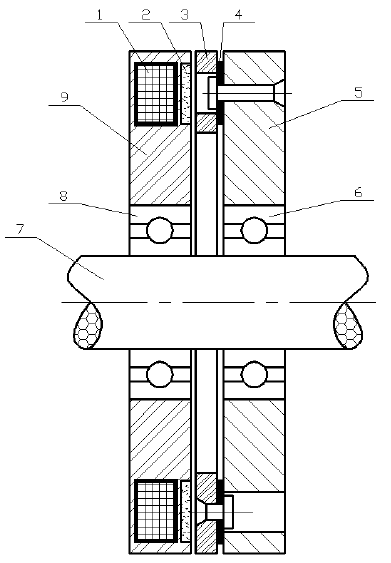
Figure 2. Internal structure of the electromagnetic clutch. 1 — electromagnetic coil; 2 — friction plate; 3 — armature; 4 — leaf spring; 5 — driven plate; 6 — rolling bearing; 7 — half shaft; 8 — rolling bearing; 9 — driving plate.